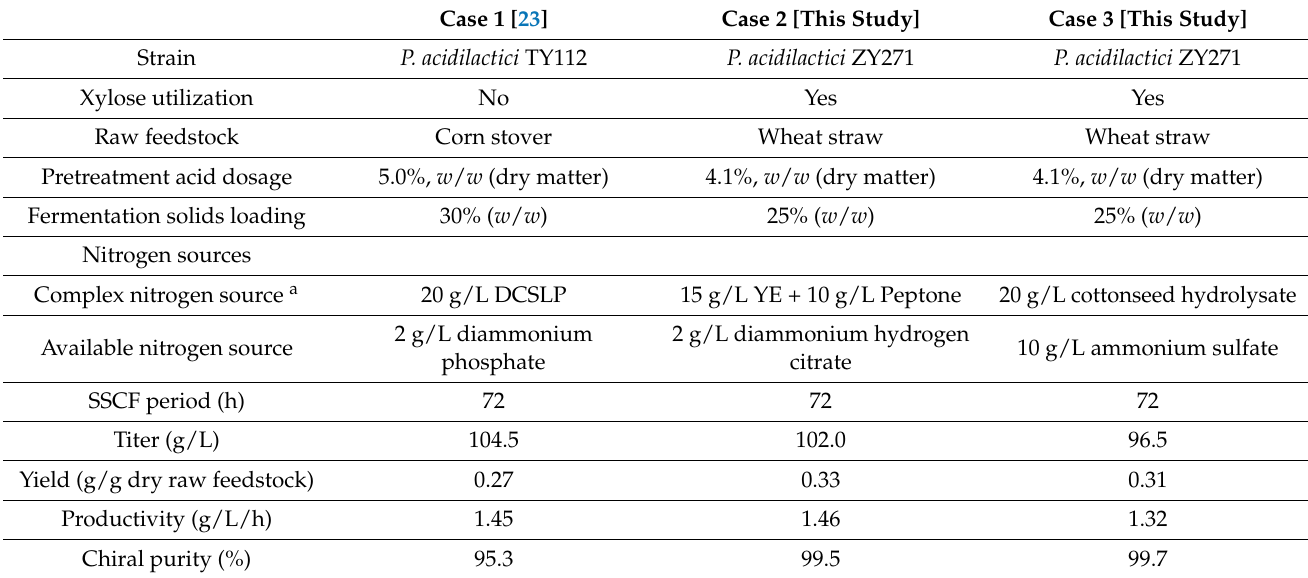
Table 4. Cellulosic L-lactic acid production parameters in different